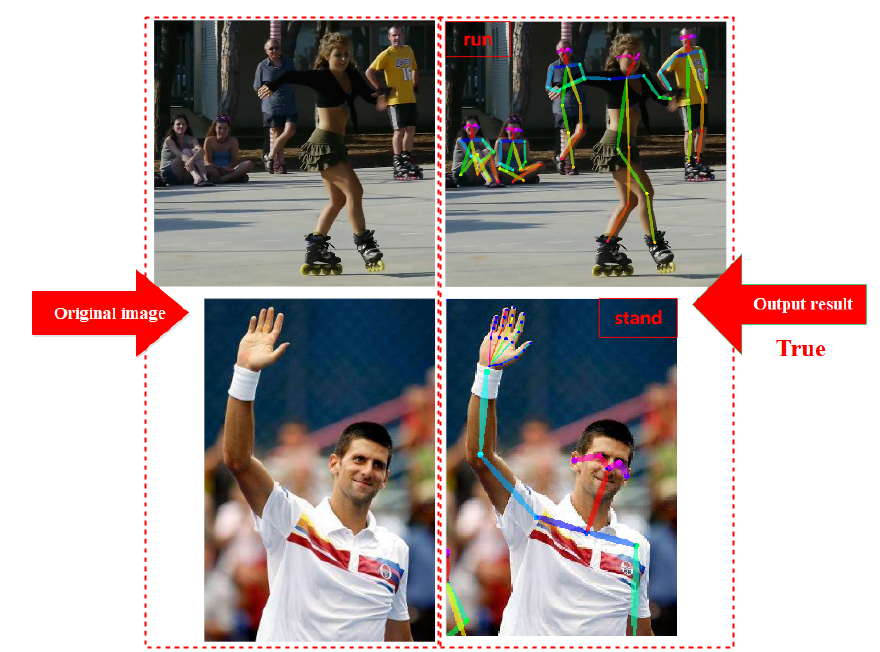
Figure 27. Schematic diagram of improved algorithm detection under machine learning.